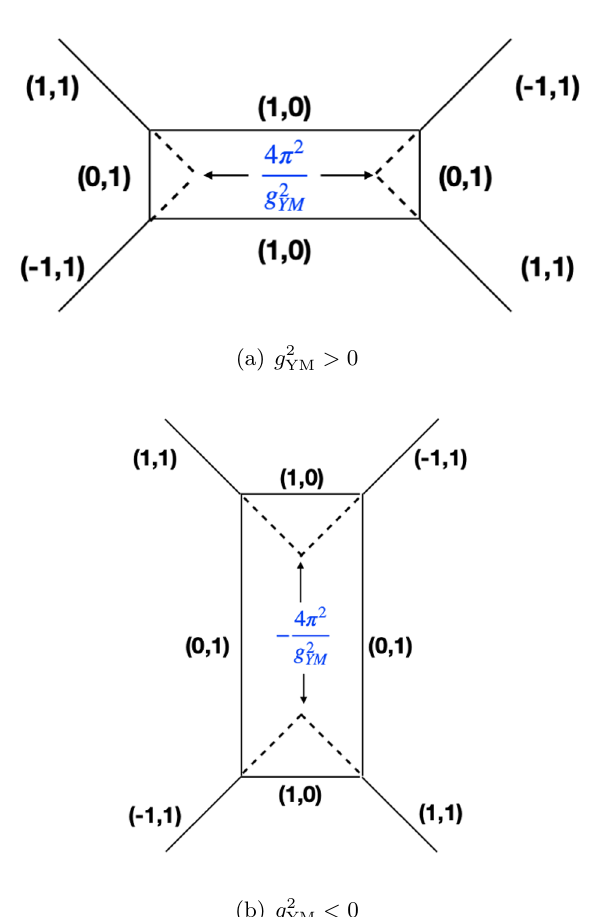
Figure 1 . ( p, q ) web for N = 1 SU(2) gauge theory at positive and negative coupling. D5 branes are (1 , 0) branes and NS5 branes are (0 , 1) . The coupling is determined by the positions of the fixed ( ± 1 , 1) external